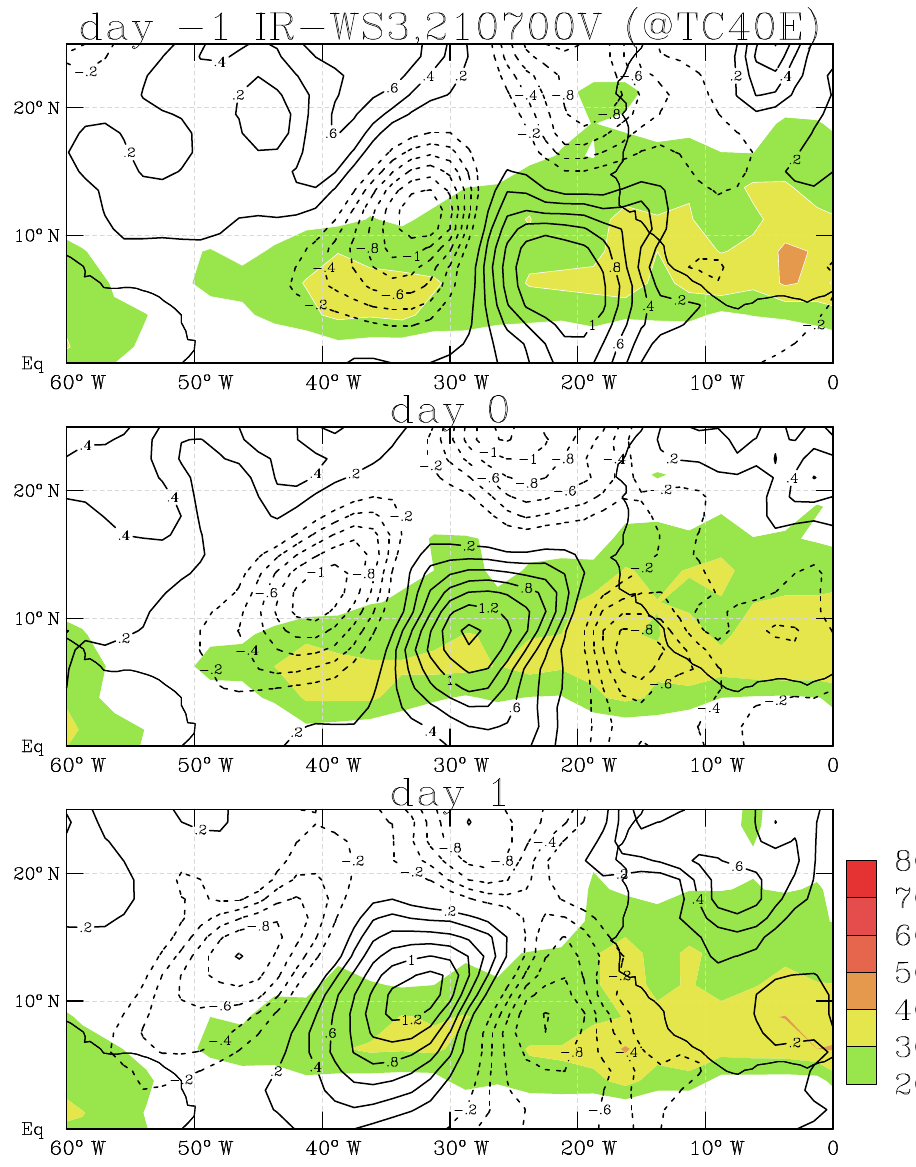
Figure 9. Composites of IR-WS3 (shaded every 10% from starting from 20%) and 2–10 day filtered 700 hPa meridional wind (contoured every 0.2 m/s). Composites are constructed based on dates of tropical cyclone genesis over the region 40°–20° W.